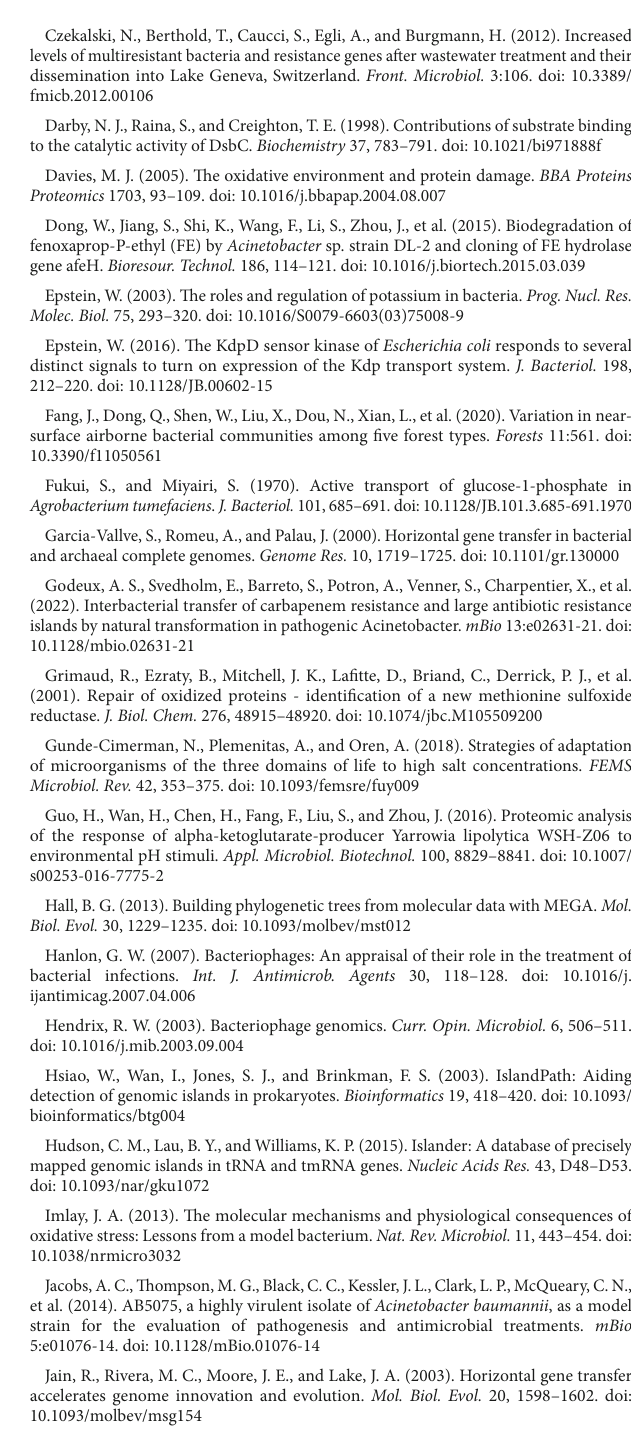
signaling. Classes J, K, and L are involved Information storage and processing. Classes C, G, E, F, H, I, Q and P are involved in Metabolism. Classes R and S belong to the category of Poorly characterized. SUPPLEMENTARY FIGURE S3 Comparison of alkM, almA, catA, benA and benB genes with the G+C content of strain genome. (A) alkM gene and genome. (B) almA gene and genome. (C) catA gene and genome. (D) benA gene and genome. (E) benB gene and